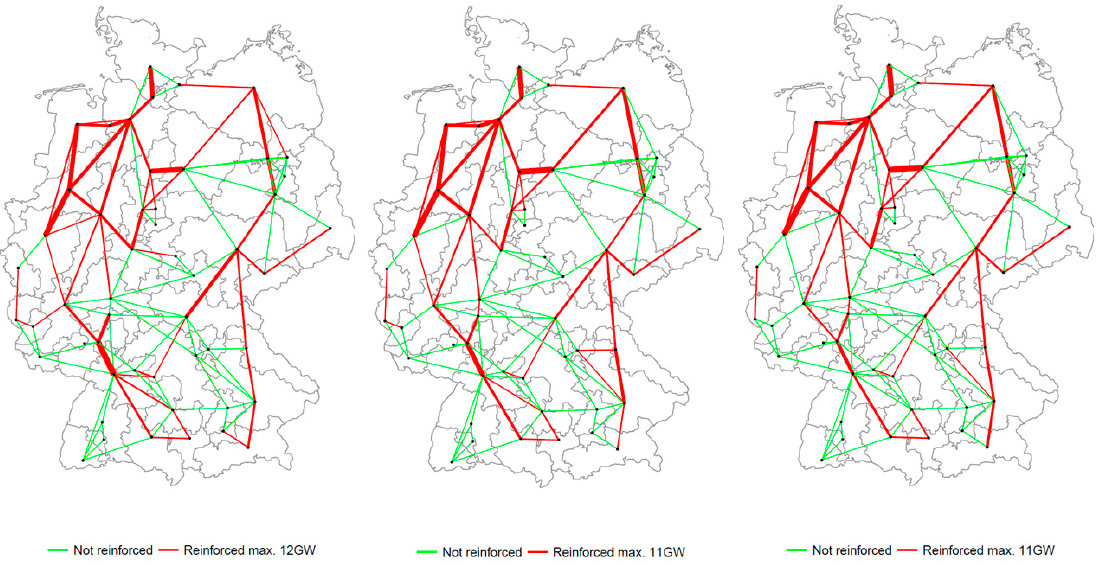
Figure A2. Overlaying grid expansion in the year 2050 in the scenario “Completion and enthusiasm—decentral” for the variants no self-supply targets ( left ), plausible self-supply targets ( middle ) and 100% self-supply targets ( right ).